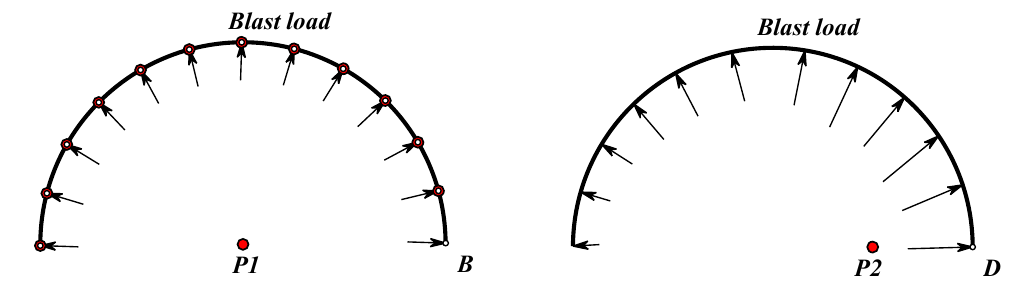
Figure 15. The plot of blast load in the condition of P1 and P2.